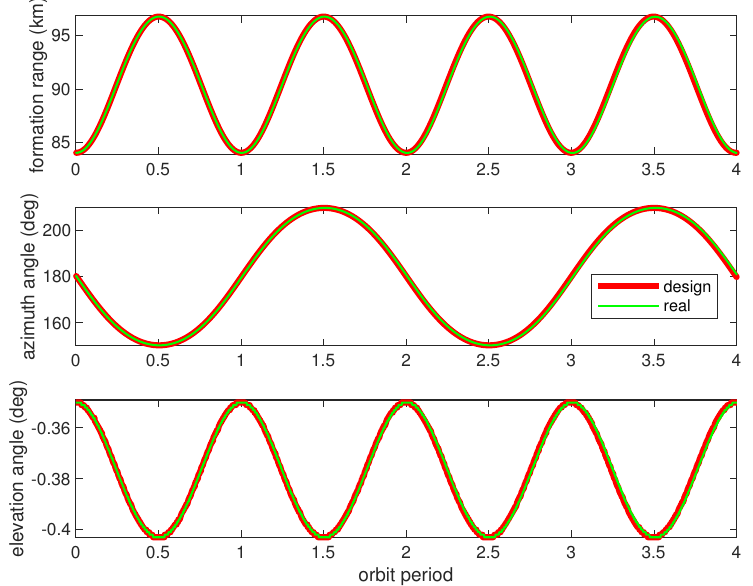
Figure 12. Formation range and azimuth/elevation angles (designed and real values). The red lines denote the designed SFF relative range ( top ), relative azimuth angles ( middle ), and relative elevation angles ( bottom ) during 4 orbit periods, and the green lines denote the same values of SFF in real orbit